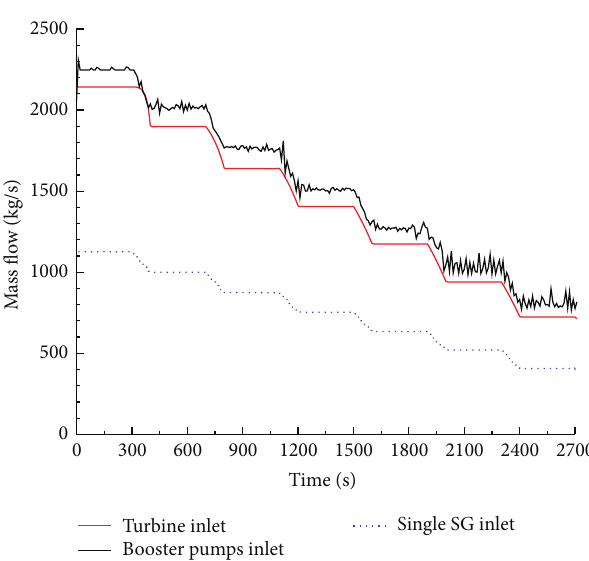
Figure 4: Transient change of mass flow for turbine inlet, booster pump inlet, and single SG inlet.